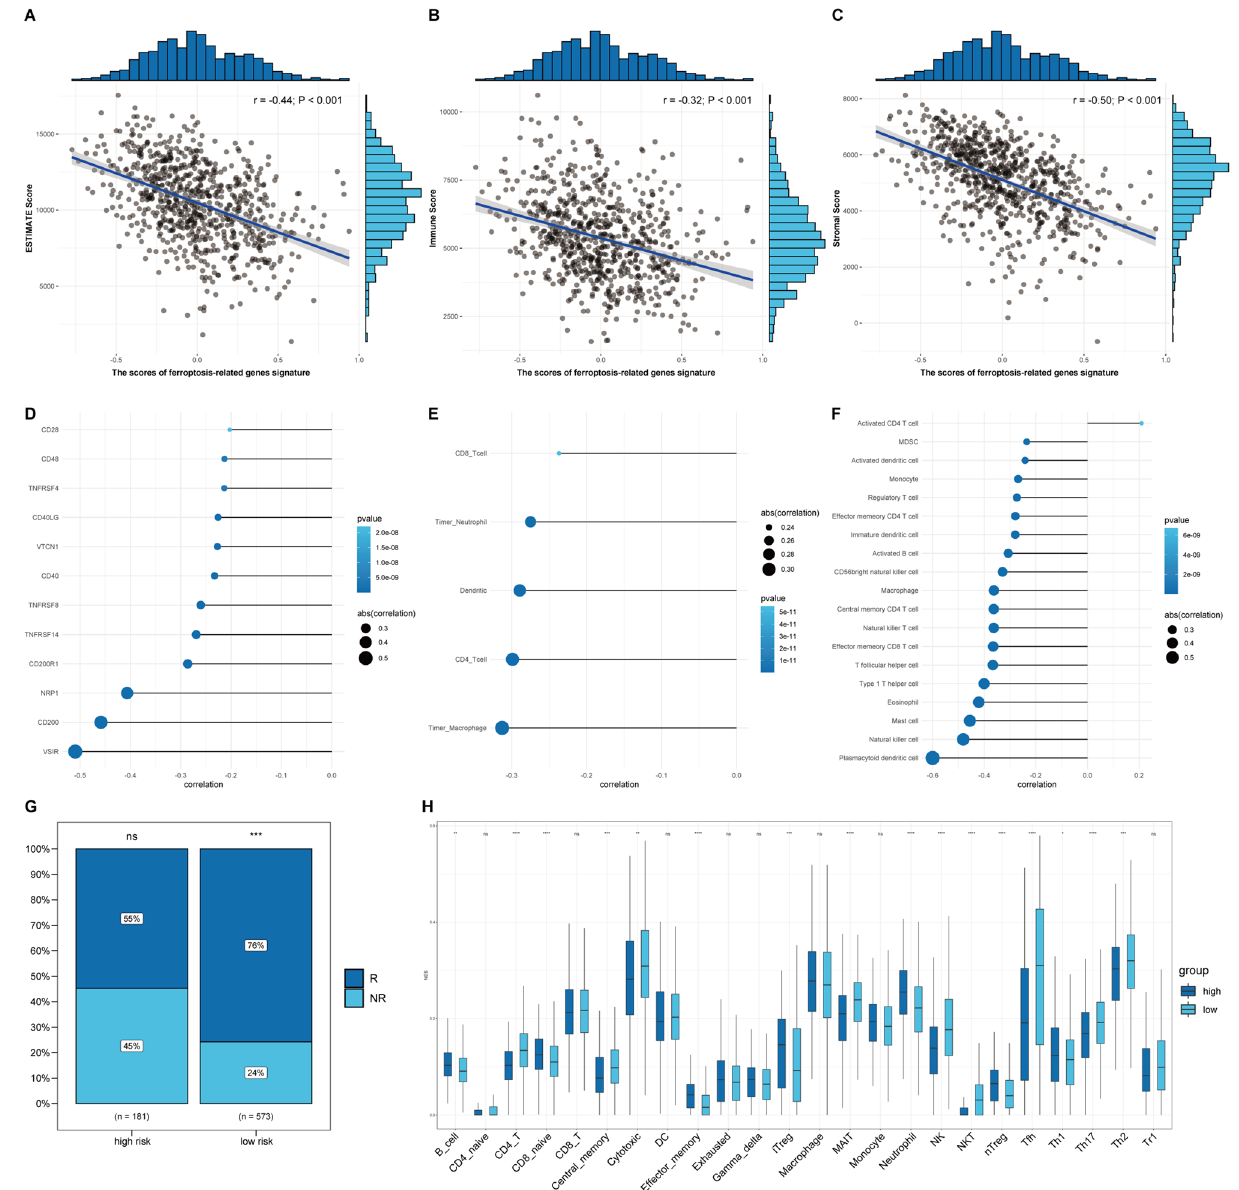
Figure 6. Correlation analysis of immune-related scores and ferroptosis-related gene signature scores. ( A – C ) The correlation analysis showed that the estimated score ( r = − 0.44; P < 0.001) ( A ), immune score ( r = − 0.32; P < 0.001) ( B ) and stromal score ( r = − 0.50; P < 0.001) ( C ) were negatively correlated with the risk score of the ferroptosis-related gene signature. ( D – F ) The results of Spearman’s correlation analysis of common immune checkpoint genes ( D ), infiltration cell scores from TIMER ( E ) and immune infiltration cell scores from TCIA ( F ) ( r > 0.2 and P < 0.05). ( G ) The ratio of immunotherapy response is greatly elevated in the low ferroptosis- related gene signature score group. ( H ) The immune infiltration scores of high- and low- ferroptosis-related gene signature score groups in the TCGA